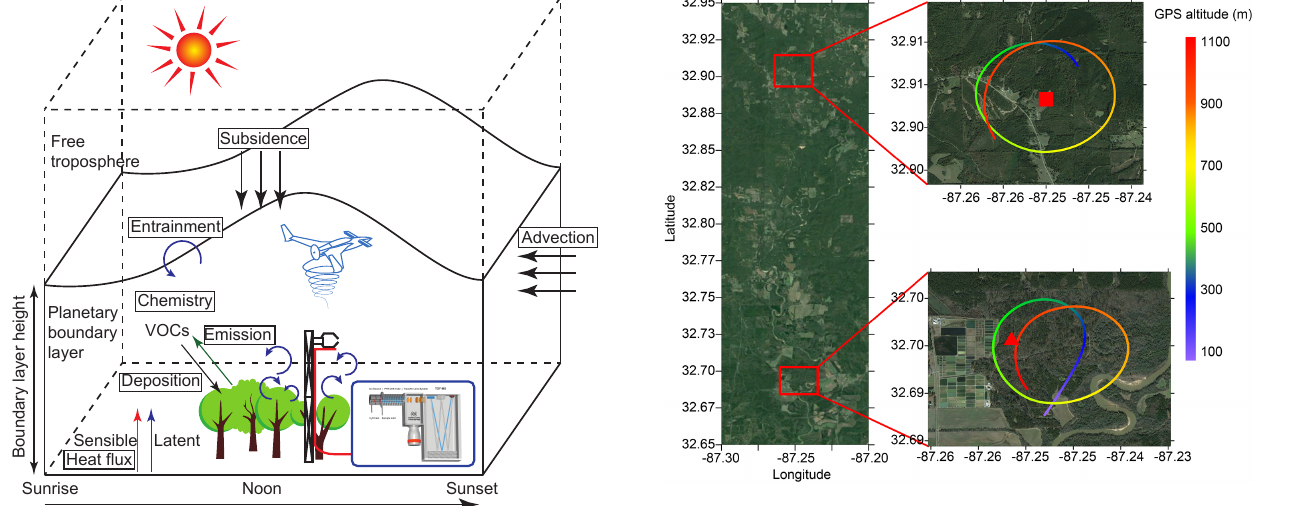
Figure 2. Location of the two ground-based sampling sites and typ- ical flight tracks of Long-EZ aircraft. The left panel shows the lo- cations of the SEARCH site (upper red rectangular area) and the AABC site (lower red rectangular area). The two panels on the right side show the typical flight tracks carried out on 12 June over the two sites. The solid red square and solid red triangle indicate the location of the sampling towers at the SEARCH site and the AABC site, respectively. The GPS altitude of both flight tracks are color- coded and indicated by the legend on the right. The maps were ob- tained from Google